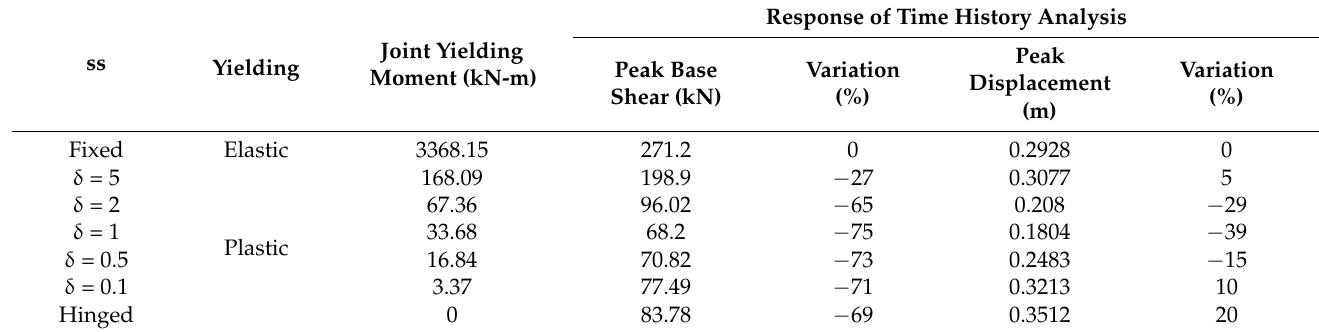
Table 1. Result of analysis by joint properties.